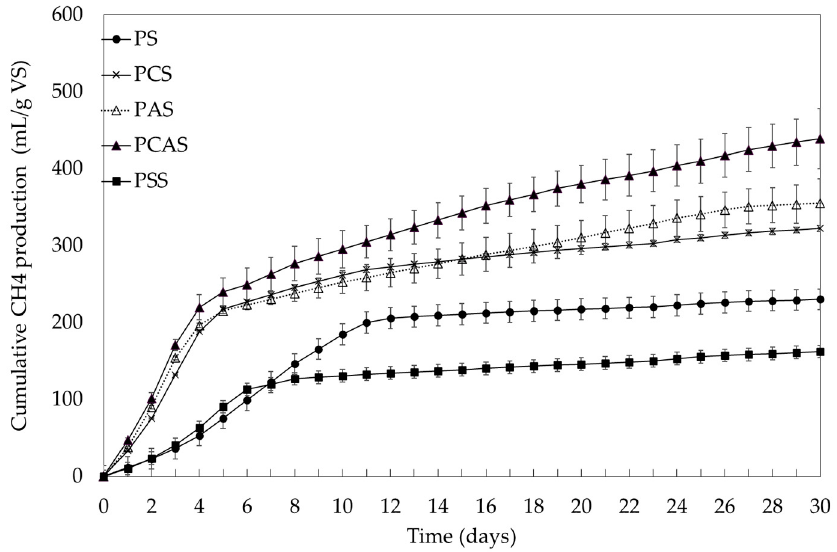
Figure 5. Cumulative methane production (mL/g VS) for SIR = 1:1 g VS substrate/g VS IN (error bars indicate standard deviation of mean values).